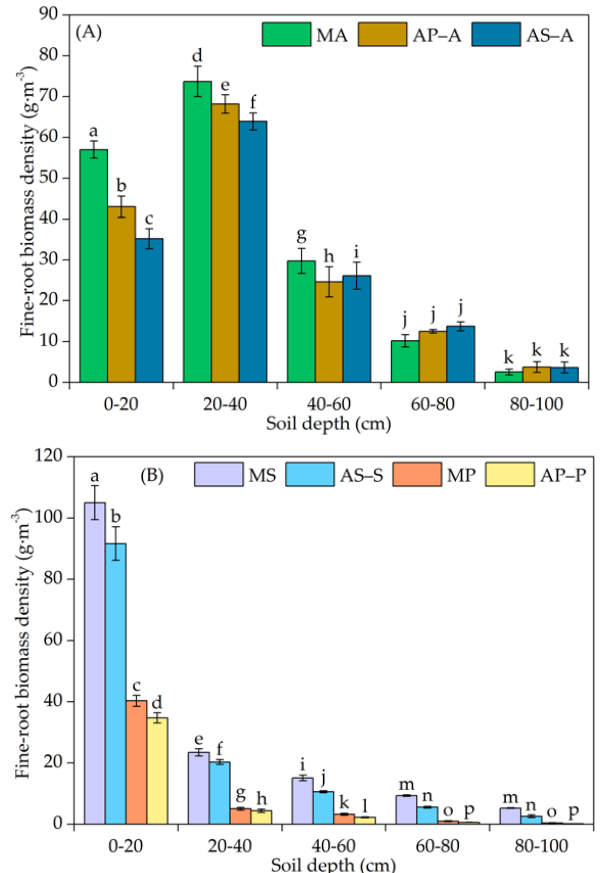
Figure 2. Vertical distribution of the fine-root biomass density (FRBD) of ( A ) monocropped